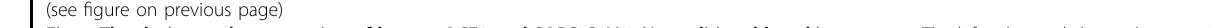
Fig. 1 The design and construction of human ACE2 and SARS-CoV-2-N conditional knockin mouse. a The left sub-panel shows the genetic organizations of the SARS-CoV-2, SARS-CoV-2 GFP/ Δ N, and related variants. The ORF encoding the N protein is replaced with GFP. The right sub-panel illustrates the concept that the SARS-CoV-2 GFP/ Δ N virus can only replicate in lungs that are expressing the N protein. b The genetic sequences encoding the human ACE2 and SARS-CoV-2 N genes were inserted together into intron 1 of the ROSA26 site located on chromosome 6. The PGK- Neo-6×SV40 pA sequence fl anked by two loxP sites. When there were both the Cre recombinase and loxP sequences, the sequence between two loxP sites (PGK-Neo-6×SV40 pA) will be removed. c Primers used for genotyping are indicated in the cartoon. Two different primers are used to con fi rm the insertion element. d The expression of hACE2 in hACE2-N heterozygous, homozygous, and control mice ( n = 5) assessed using qPCR. e Mouse lung tissue lysates were subjected to SDS PAGE followed by western blot with ACE2 antibody (recognize both human and mouse ACE2). f Mouse lung tissue lysates were subjected to SDS PAGE followed by western blot with HA antibody. g Immuno fl uorescence staining of lung sections with anti-ACE2 (green) antibody (recognize both human and mouse ACE2) and 4,6-diamidino-2-phenylindole (DAPI, blue) for evaluating hACE2 expressing cells in the lungs of hACE2-N F/F mice. The two white frames are magni fi ed at the right. h Immuno fl uorescence staining of lung sections with anti-HA (red) antibody and DAPI (blue) for evaluating SARS-CoV-2 N expressing cells in the lungs of Sftpc-hACE2-N F/F mice. Two white frames are magni fi ed at the